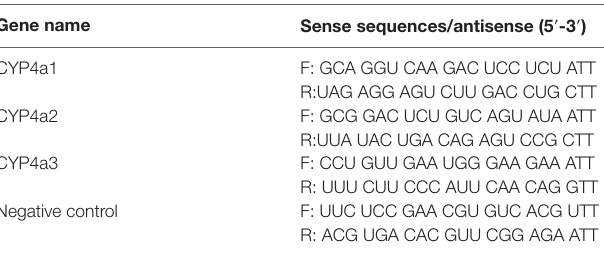
TABLE 1 | Synthetic primers for siRNAs.